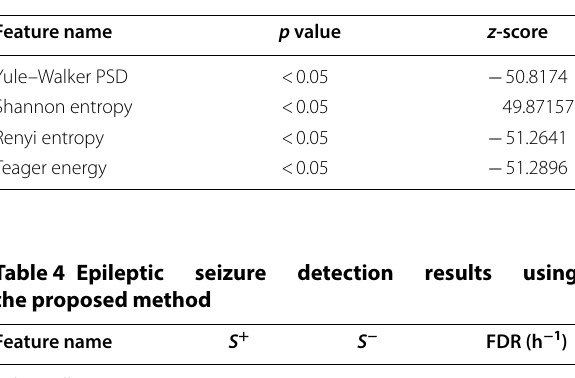
Table 3 Wilcoxon rank-sum test results